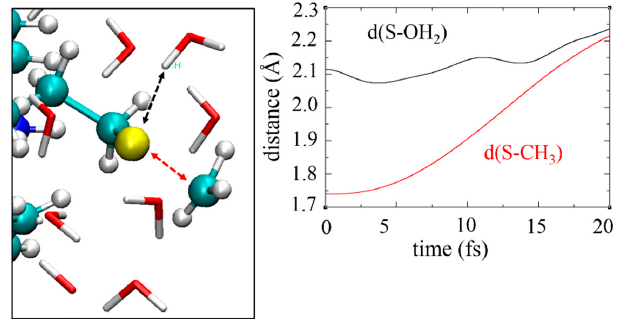
Figure 13. Fragmentation of methionine side chain after collision by high energy proton. Left: snapshot at 20 fs. Right: evolution of two distances involving S atom.